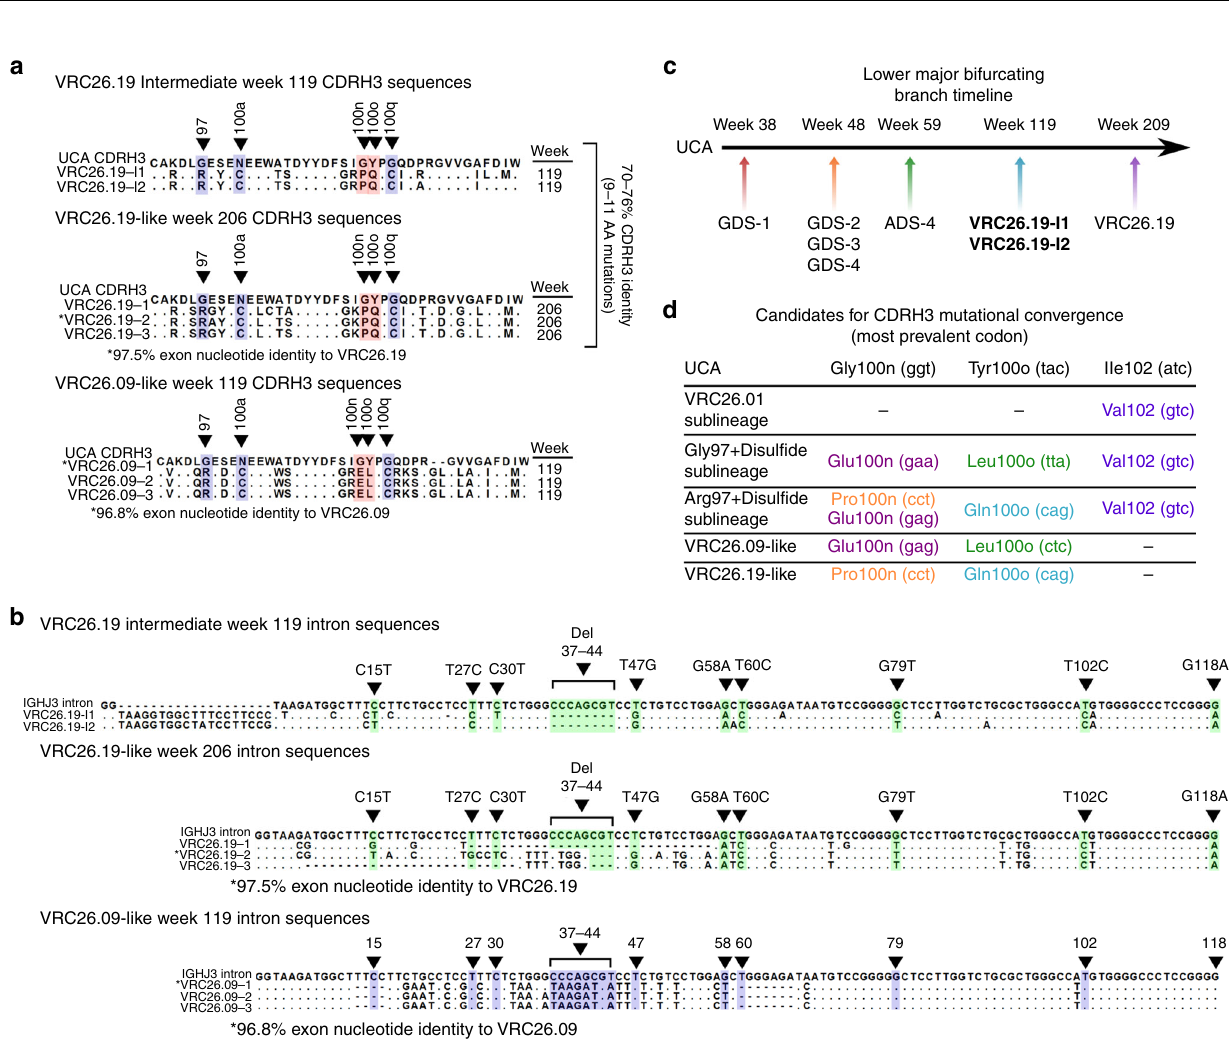
Fig. 7 Late-stage bNAb intermediates and intraclonal convergence. a CDRH3 alignment of potential VRC26.19 intermediates (VRC26.19-I1, VRC26.19-I2), VRC26.19-like sequences (VRC26.19-(1 – 3)) and VRC26.09-like sequences (VRC26.09-(1 – 3)). VRC26.19-related sequences are highly diverse when compared between the two time points with about 70 – 76% CDRH3 amino acid identities between members of the two groups. CDRH3 sites containing residues that are candidates for intraclonal convergence throughout the lineage are marked in red. Sites with CDRH3-stabilizing mutations are marked in blue. b Alignment of the introns of the sequences shown in a . SHM events (point mutations or indels) that are shared between at least one member of each time point for VRC26.19-related sequences are marked with arrows and labeled according to germline positions. The same sites are marked for VRC26.09- like sequences for comparison. c Lower major bifurcating branch timeline with the potential intermediates for VRC26.19 indicated in bold. d List of sublineages and their candidate convergent CDRH3 mutations with the most prevalent codon